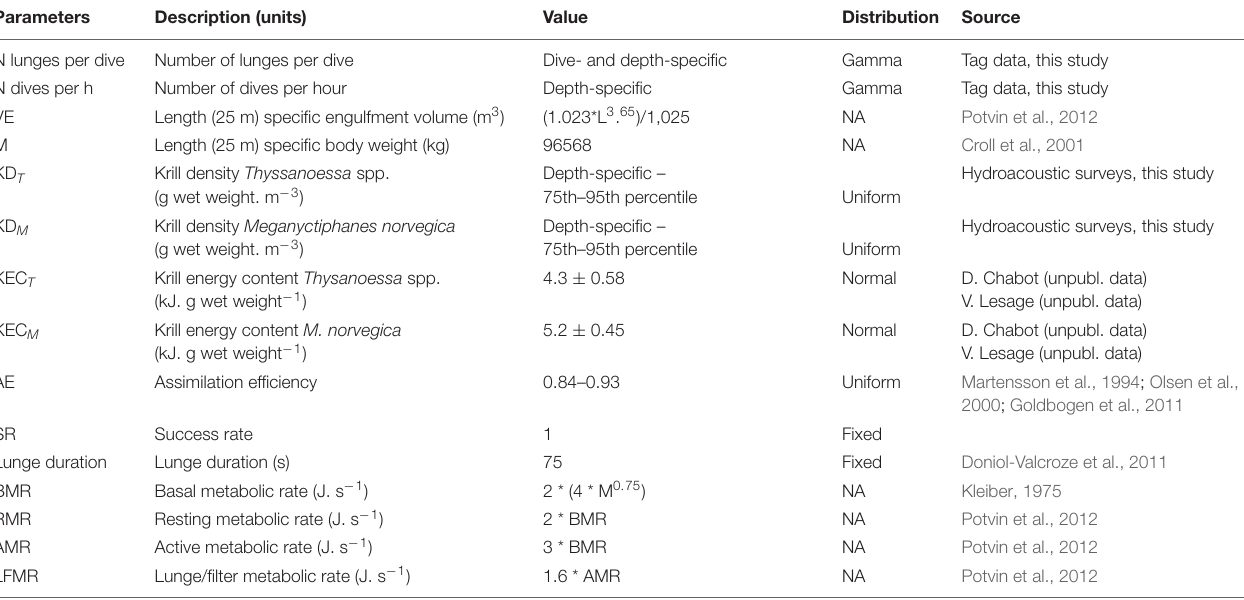
FIGURE 1 | Bioenergetic model framework to assess immediate effects on net energy gain of changes in preyscape as a result of ocean warming or in prey access as a result of vessel proximity. Parameters and their value are provided in Table 1 . TABLE 1 | Input parameters, associated sampling distributions and/or values and, data sources used in the bioenergetic framework for estimating net energy gain.